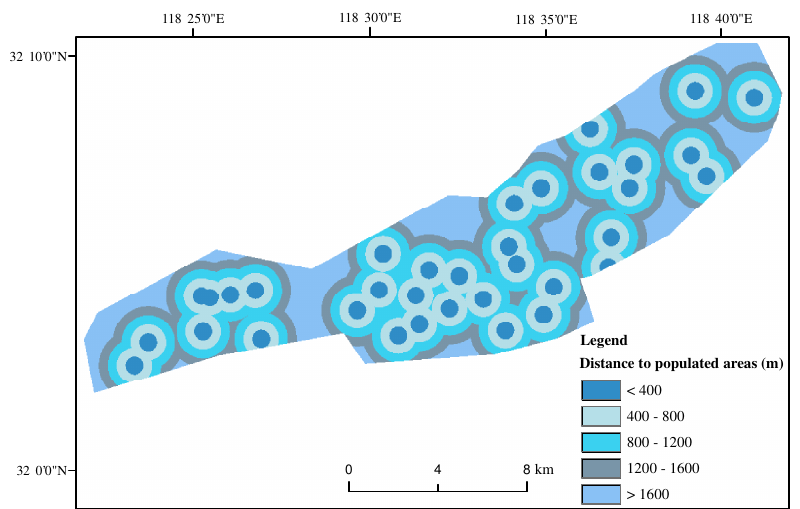
Figure 9. The base map of distance to roads in Laoshan. Each level is determined by the fire risk classification.